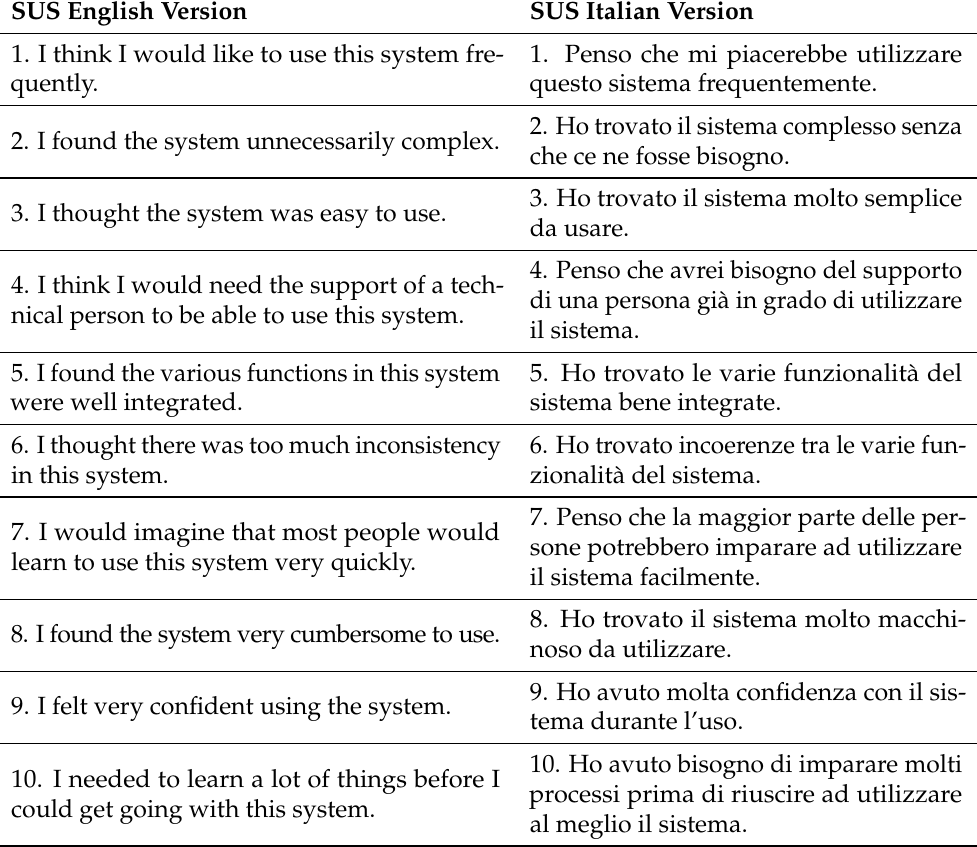
Table 4. system usability scale (SUS), English and Italian versions. The table reports the SUS items for English and Italian.